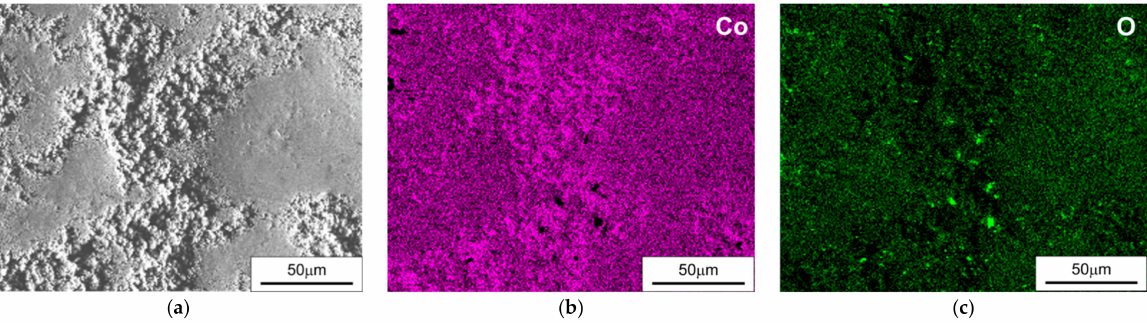
Figure 2. SEM image and EDX mapping analysis of the fresh catalyst. ( a ) SEM picture of the analyzed catalyst’s surface, ( b ) distribution of cobalt, and ( c ) distribution of oxygen.